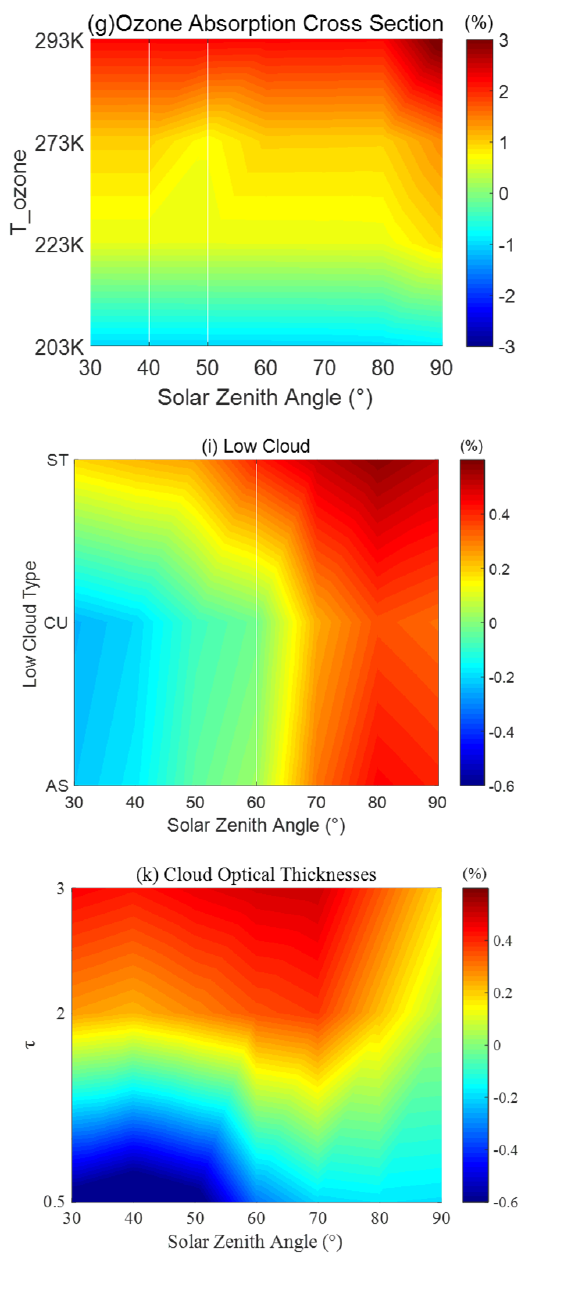
Figure 10. Distribution of the ozone retrieval errors for error sources with SZAs. ( a ) A priori profiles; ( b ) surface albedo; ( c ) aerosol; ( d ) aerosol extinction coefficient; ( e ) pressure; ( f ) temperature; ( g ) temperature of ozone absorption cross section; ( h ) tangent height; ( i ) low cloud; ( j ) high cloud; ( k ) cloud optical thickness; ( l ) random noise.